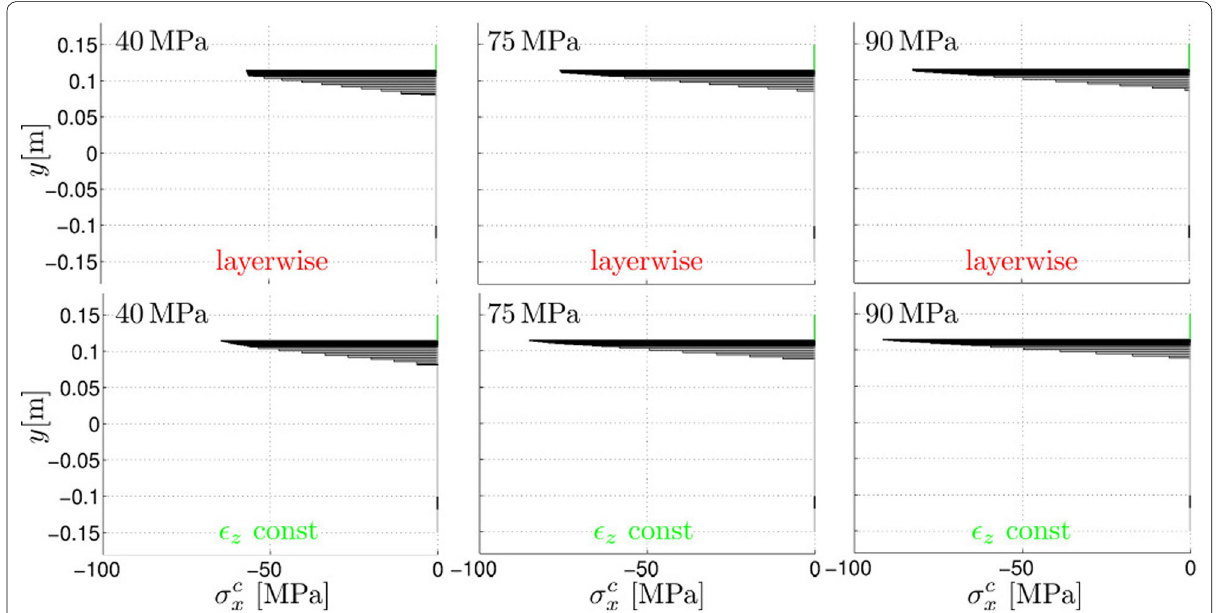
Fig. 13 Axial stress distribution in concrete for different stirrup formulations in the cross section of a FE close to mid-span at point D in Fig.